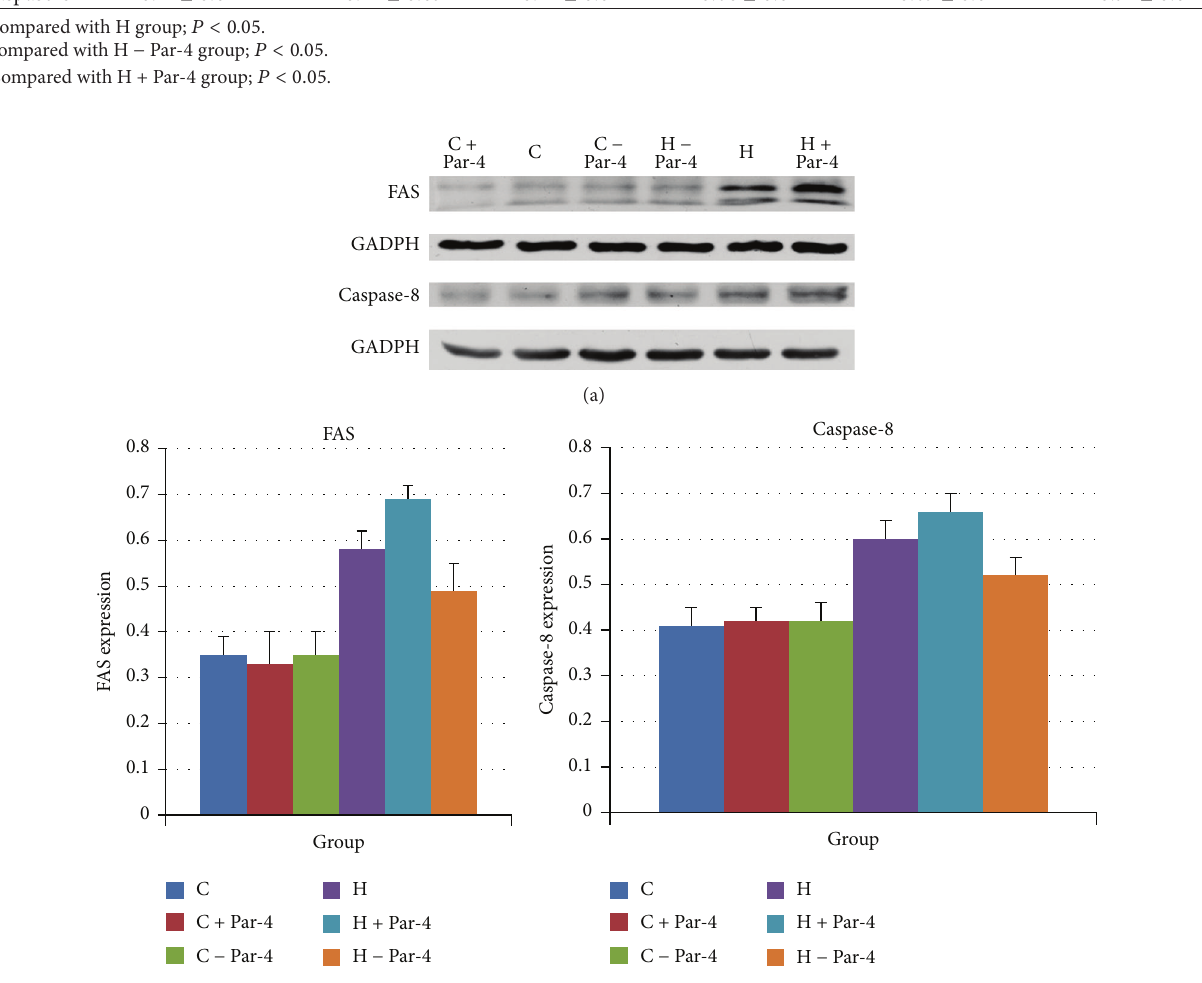
nuclear protein expression by WB. Compared to the